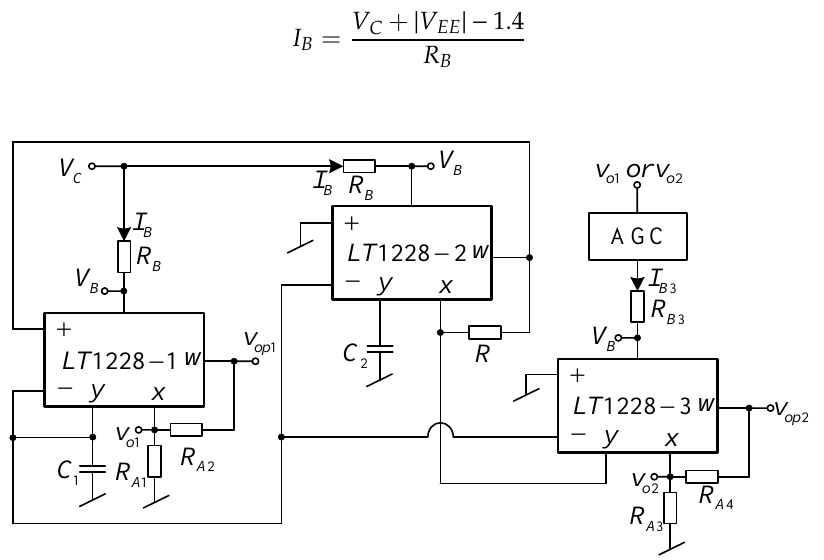
Figure 6. Proposed quadrature sinusoidal oscillator with voltage control and automatic gain control (AGC).